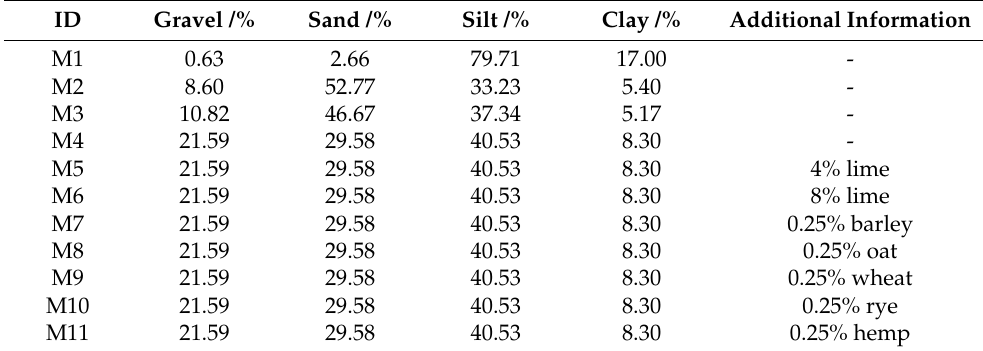
Figure 5. Cereal straw and hemp fibers used for mixtures M7–M11. Table 3 provides a detailed presentation of the basic data on mixtures M1–M11. Table 3. Composition of observed mixtures.